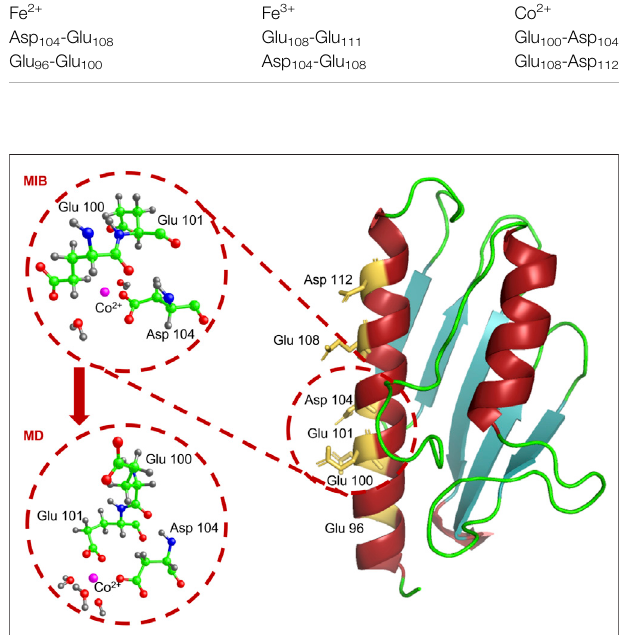
FIGURE 9 | We show the atomic structure of the Glu 100 -Asp 104 site around the Co 2+ ion, as proposed by MIB (upper circle) and at the end of the